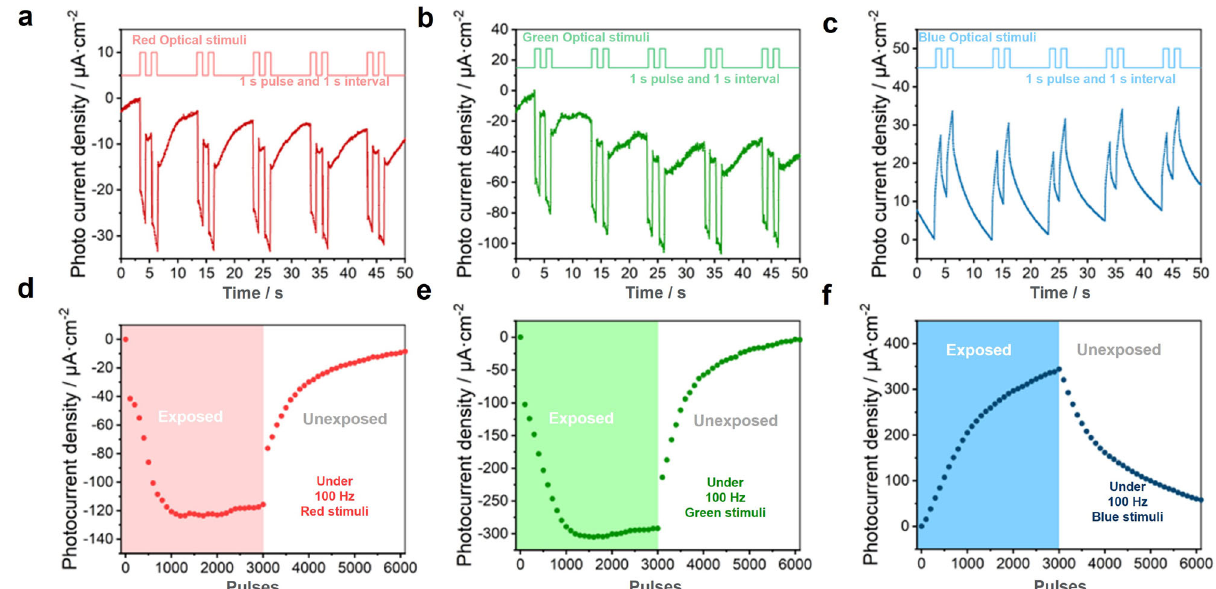
Fig. 2 | Bidirectional synaptic photo response under 0V. a – c Photocurrent density under 11mW/cm 2 a red (650nm), b green (520nm), and c blue (405nm) illumination with 1s pulse width and 1s pulse interval for 5 cycles under 0V